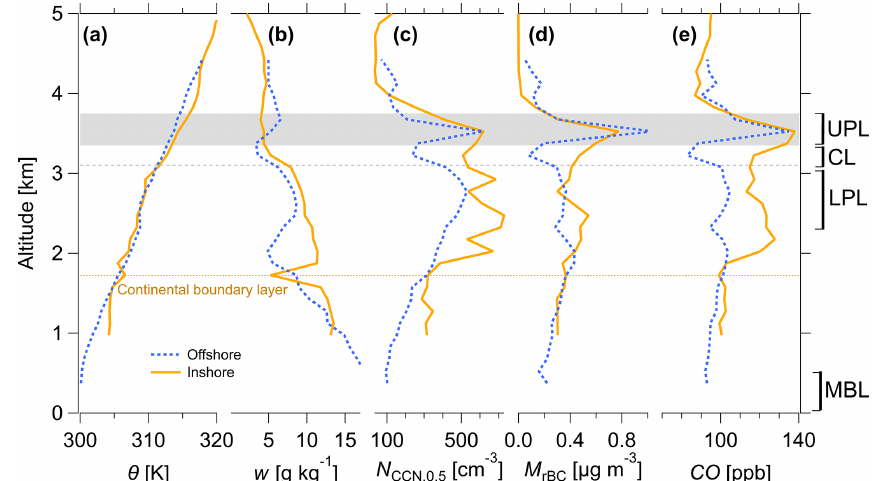
Figure 11. Vertical profiles of selected meteorological, aerosol, and trace gas parameters measured inshore and offshore of the Brazilian coast during AC19: (a) potential temperature, θ ; (b) water vapor mass mixing ratio, w ; (c) CCN ( S = 0 . 5%) number concentration, N CCN , 0 . 5 ; (d) rBC mass concentration, M rBC ; and (e) carbon monoxide mole fraction, c CO . The figure shows the medians calculated for 150m altitude bins over the flight sections inshore (yellow) and offshore (blue) of the Brazilian coast (as indicated in Fig. 1). The grey shaded area represents the approximate vertical location of the upper pollution layer (UPL) and the grey dashed line the lower limit of the clean layer (CL) observed exclusively during the offshore